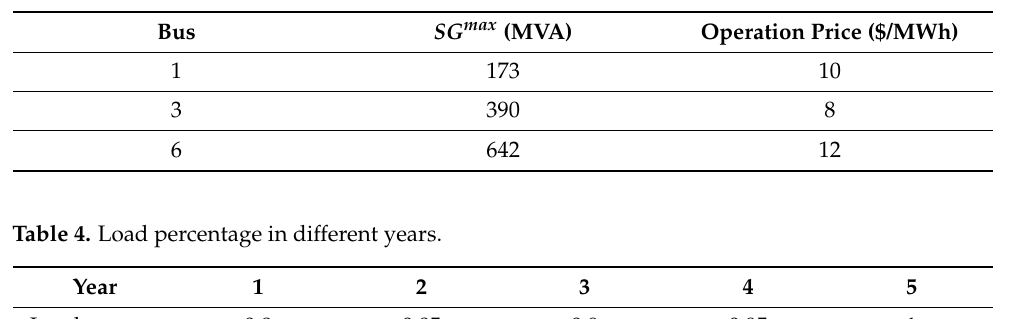
Table 3. Generator characteristics of 6-bus network [47].